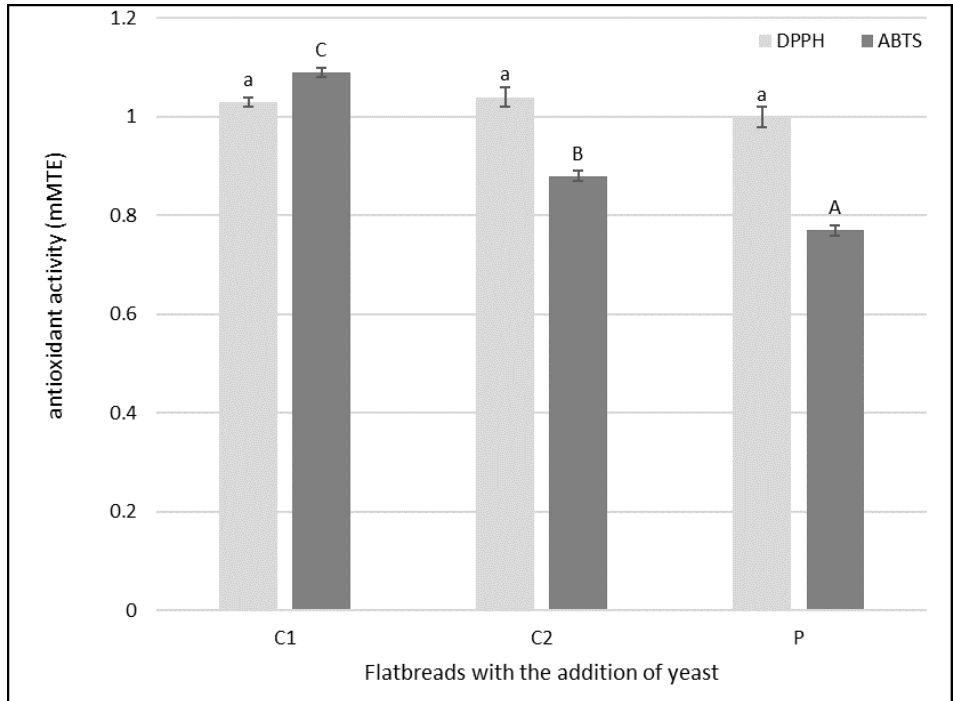
Figure 1. Antioxidant properties of flatbread produced with yeast not enriched with iron ions (C1), with yeast enriched with iron ions without PEF(C2), and with yeast enriched with iron ions using PEF(P), expressed as Trolox equivalent antioxidant activity. Each value is the mean ± standard deviation ( n = 3). Bars with the same letter are not significantly different ( p < 0.05). Table 4. Results of the flatbread evaluation with the 5-point rating